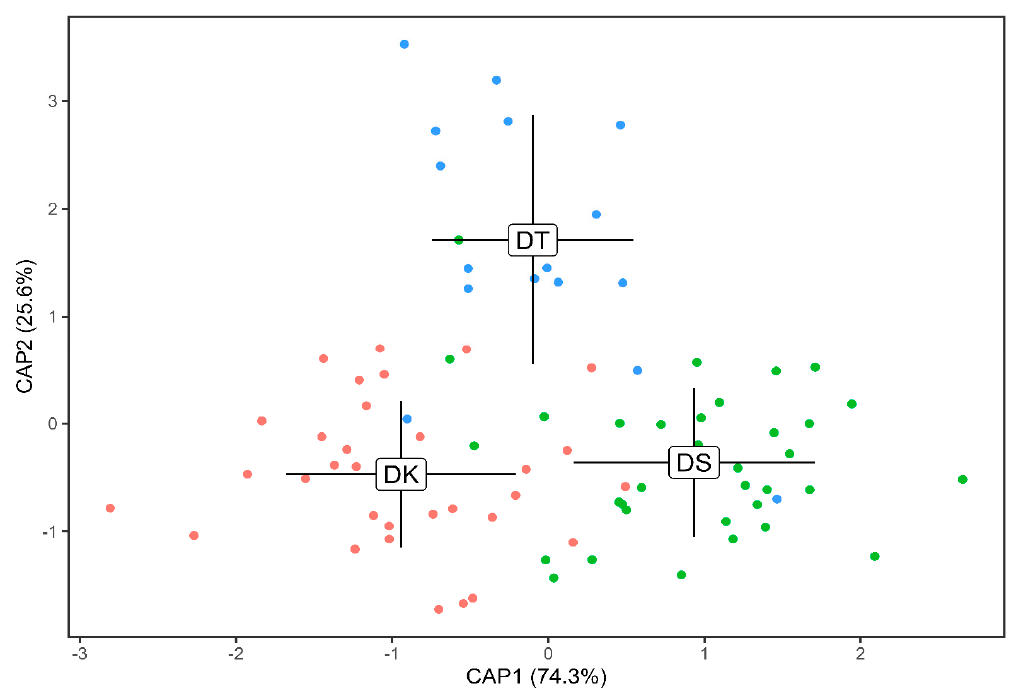
Figure 6. Plot showing mean otolith shapes of the three redfin Decapterus species from Sulu Sea, Philippines, using canonical analysis of principal coordinates (CAP) with the wavelet coefficients. Labels represent species and the mean canonical values, while surrounding points denote each individual fish of the same species (red—DK, green—DS, blue—DT). DK— Decapterus kurroides; DS— D. smithvanizi; DT— D. tabl. Lines surrounding the labels are the standard deviations (mean (cid:3399) SD) in both CAP1 and CAP2.